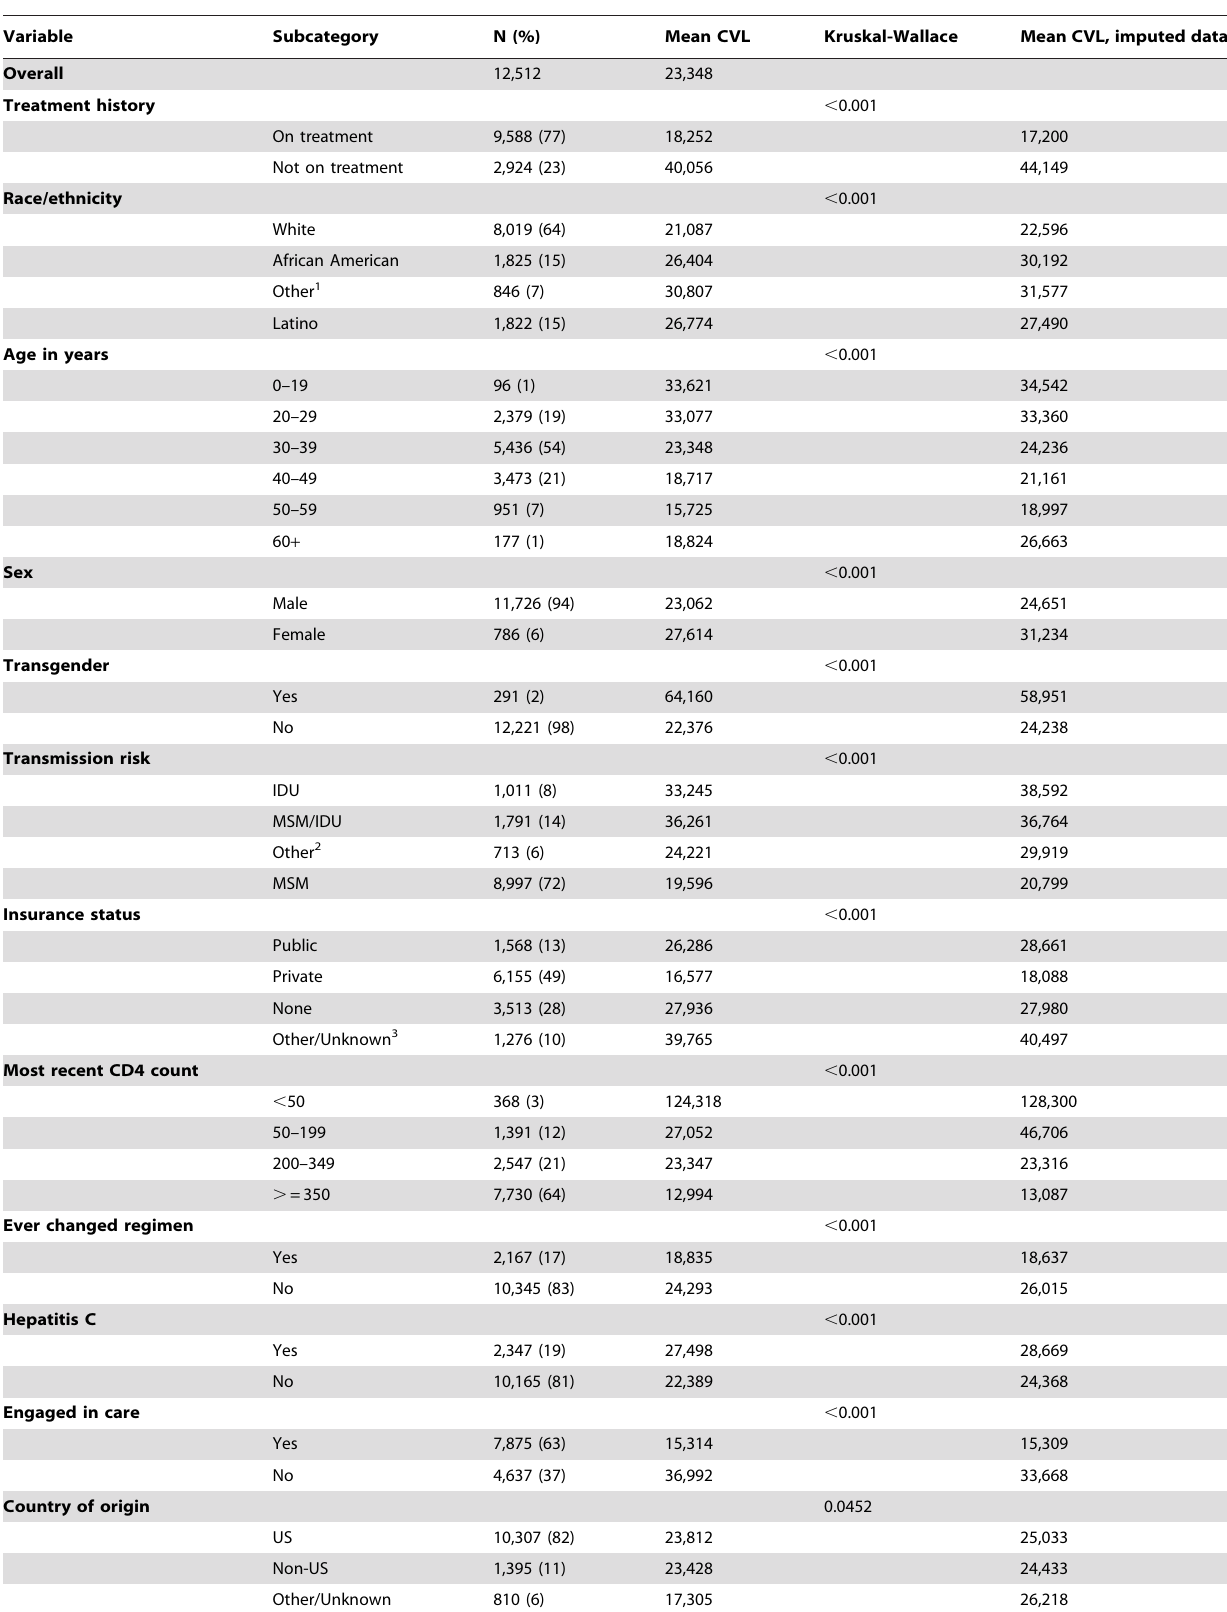
Table 1. Characteristics of HIV-positive persons and mean community viral load (CVL), San Francisco,